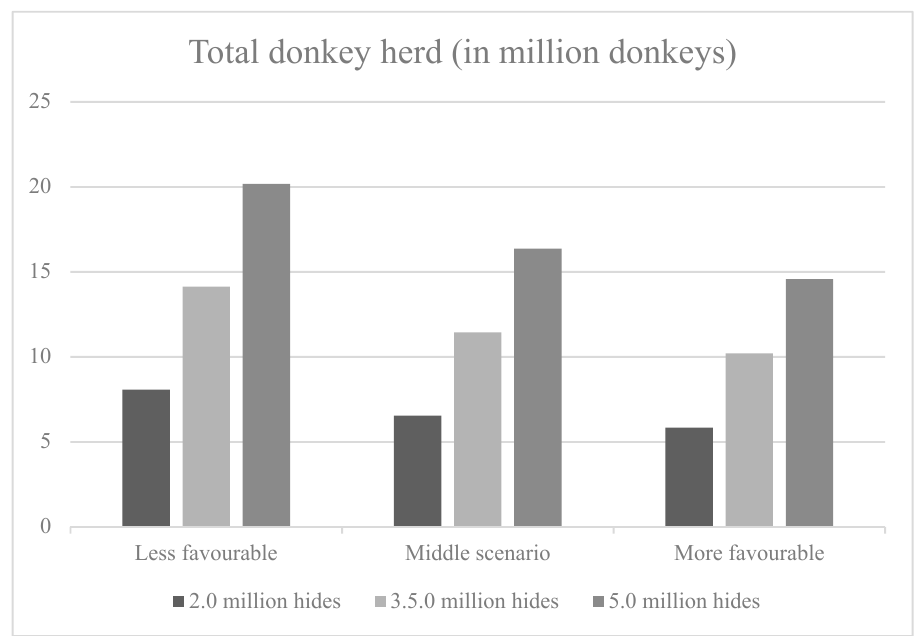
Figure 5. Total donkey herd required for the production of 2.0, 3.5 and 5.0 million hides per annum under the three scenarios.